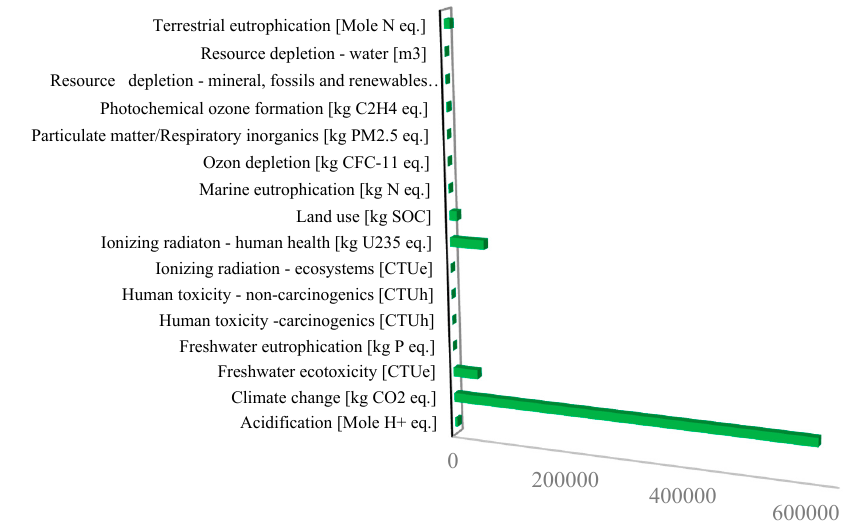
Figure 7. Total energy consumption per piece.